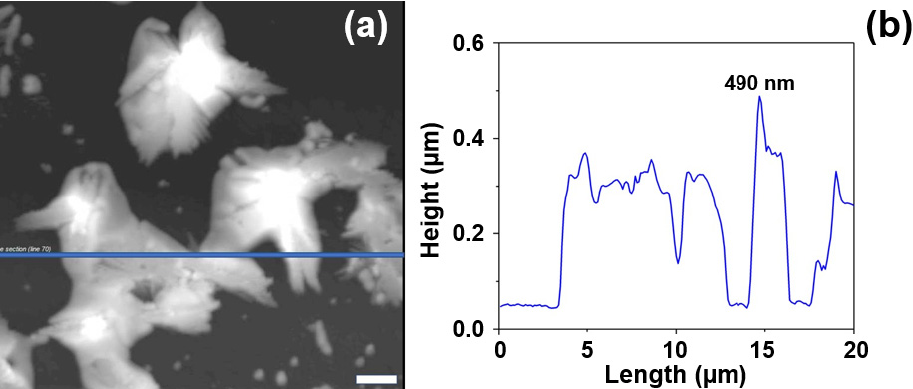
Figure 4. AFM topological image of several interconnected nanostars self-organized on the MgF 2 surface ( a ). Corresponding cross-sectional analysis of AgNS ( b ). The scale bar represents 2 µm.